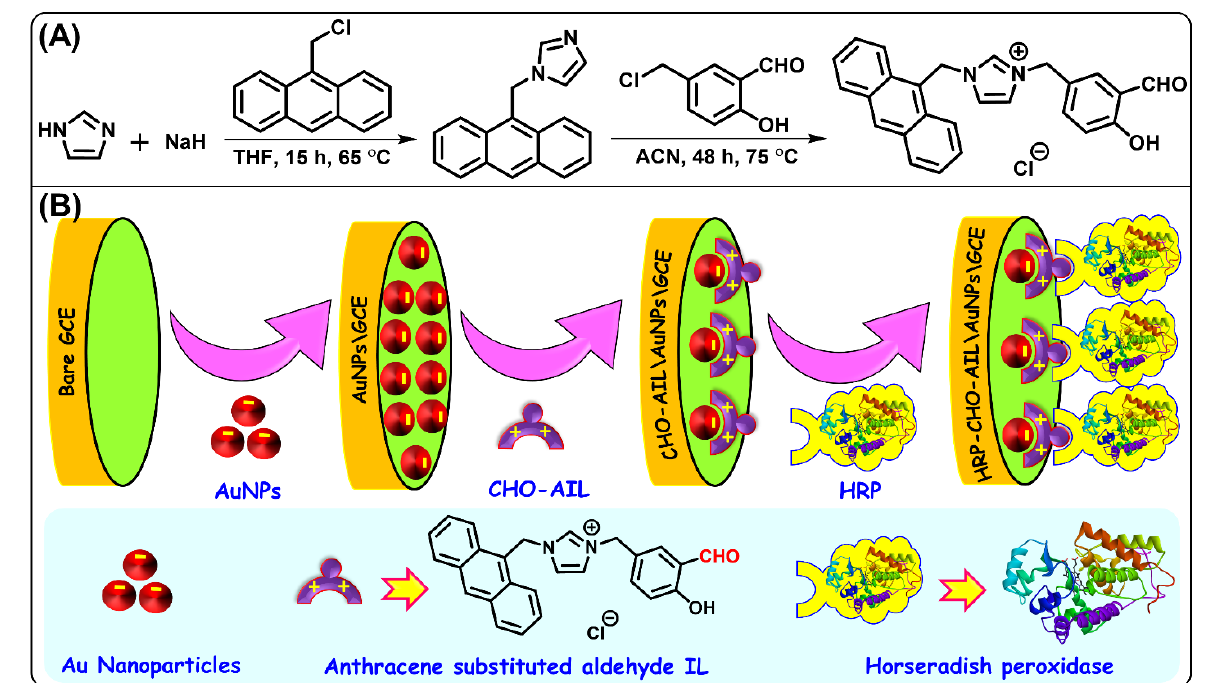
Figure 8. ( A ) Scheme for the synthesis of redox-tethered aldehyde-functionalized IL, ( B ) various steps involved in biosensor fabrication. Reproduced with permission from [153].